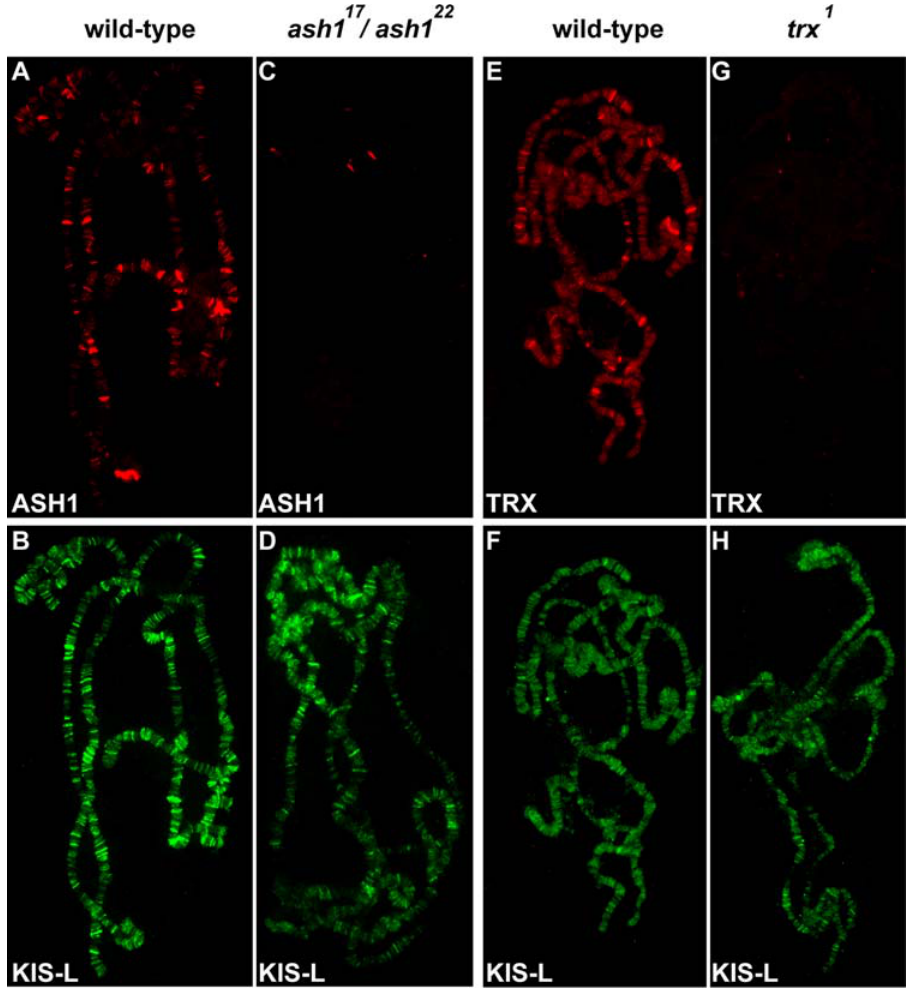
Figure 5. The association of KIS-L with chromatin is not altered in ash1 and trx mutants. A–D) The association of ASH1 (A, C, red) and KIS-L (B, D, green) on salivary gland polytene chromosomes of wild-type (A, B) and ash1 22 /ash1 17 (C, D) larvae were detected by indirect immunofluorescence microscopy. E–H) The association of TRX (E, G, red) and KIS-L (F, H, green) on polytene chromosomes isolated from wild-type (E, F) and trx 1 (G, H) larvae were detected by indirect immunofluorescence microscopy. Neither ASH1 nor TRX is required for the binding of KIS-L